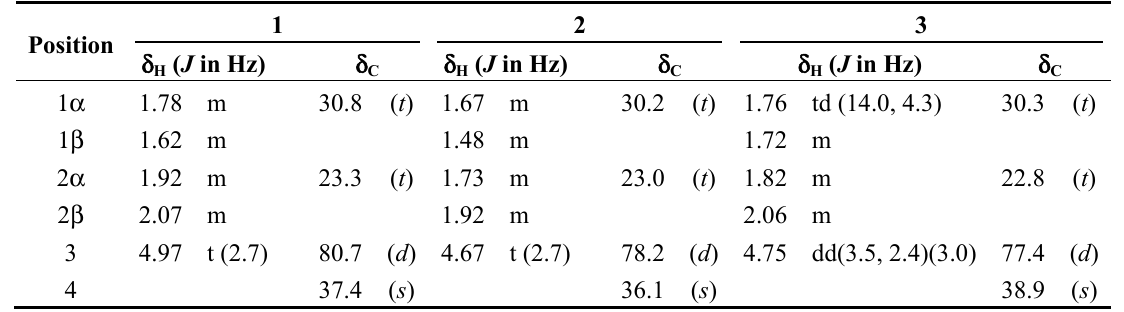
Table 1. 1 H- (500 MHz) and 13 C-NMR (125 MHz) spectroscopic data of compounds 1 – 3 (CDCl